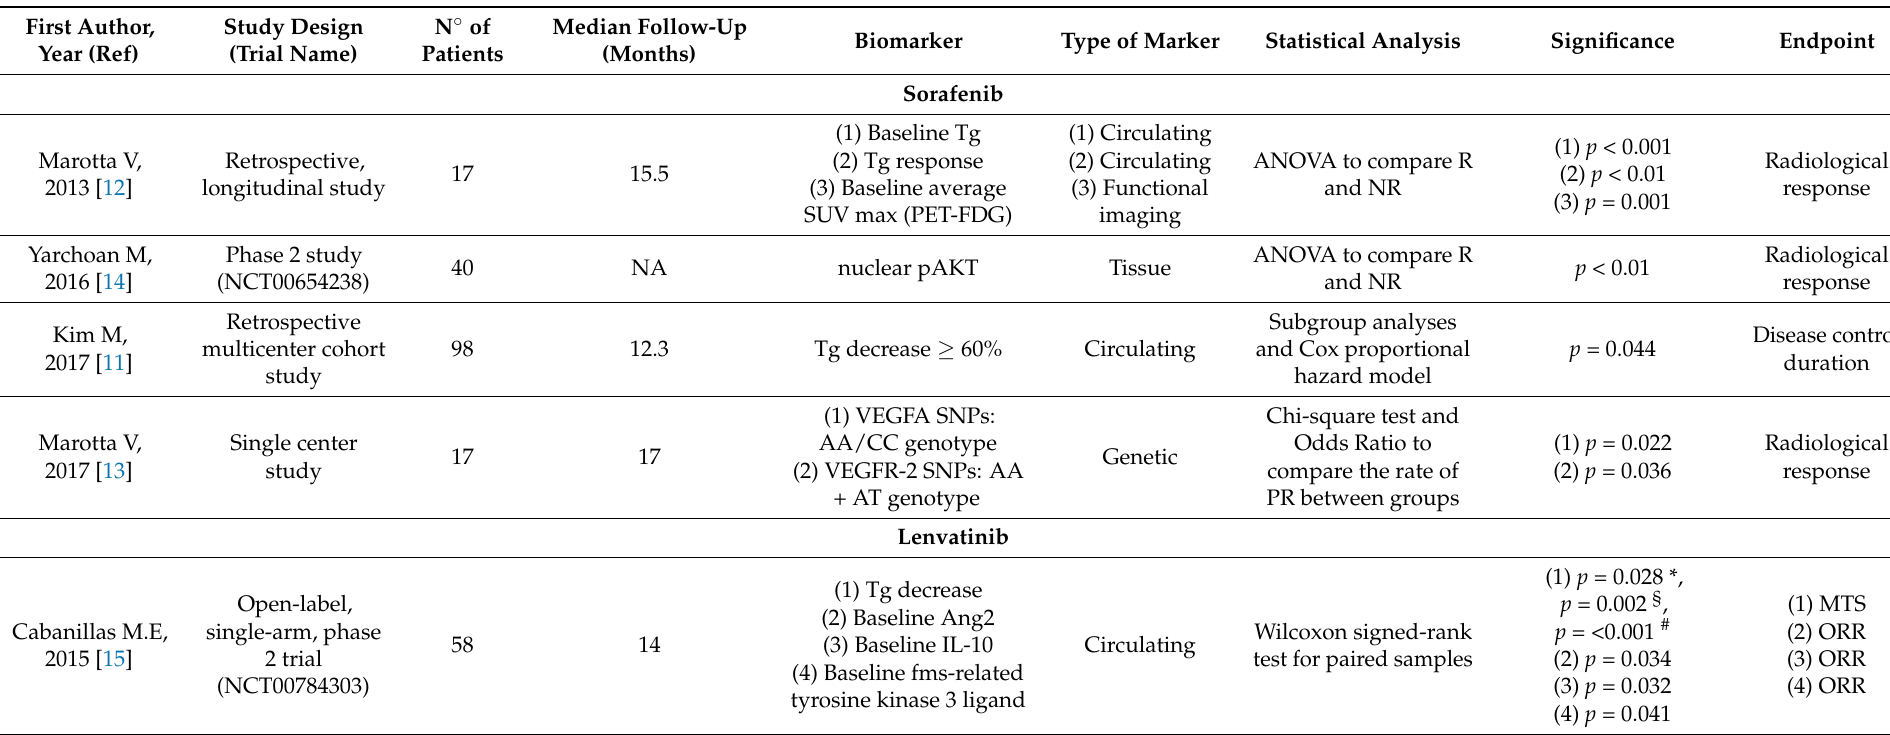
Table 1. Predictive markers of radiological response to sorafenib and lenvatinib in progressive RAI-refractory DTC. * (cycle 2), § (cycle 3), # (cycle 4-5-6), • mean ± standard deviation. DCR, disease control rate; DOR, duration of overall response; MTS, maximum tumor shrinkage; OR, objective response rate; R, responders; NR,